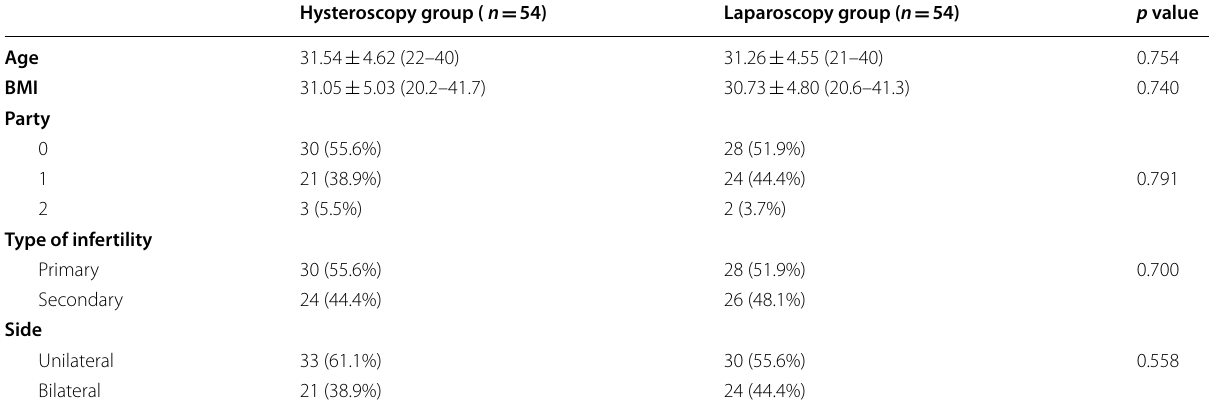
Table 1 Demographic data in both groups